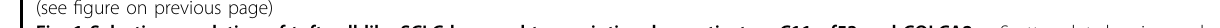
Fig. 1 Selective regulation of tuft cell-like SCLC by novel transcriptional co-activators C11orf53 and COLCA2. a Scatter plot showing each gene ’ s NormLRT score vs publication count. b Scatter plots showing speci fi c genes ’ expression levels vs CERES scores across cancer cell lines. c CellTiter-Glo assay of gRNA-treated NCI-H526 cells. PSMB3, a common essential gene, was a positive control. NT nontargeting. n = 3. d CellTiter-Glo assay of gRNA-treated NCI-H1048 cells. n = 3. e CellTiter-Glo assay of shRNA-treated NCI-H526 cells. n = 3. f CellTiter-Glo assay of gRNA-treated EGFP/ COLCA2-expressing NCI-H1048 cells. n = 3. Statistical analysis was performed within each cDNA group. g Immunoprecipitation-western blot of HEK293T cells expressing HA-COLCA2 (WT or mutant where VKELL in the motif is mutated to DAAPP) and POU2F3. Data were quanti fi ed. h Immunoprecipitation-western blot of HEK293T cells expressing FLAG-POU2F3 and HA-COLCA2-WT/DAAPP. Data were quanti fi ed. i CellTiter-Glo assay of gRNA-treated EGFP/COLCA2-WT/DAAPP-expressing NCI-H1048 cells. n = 3. Statistical analysis was performed within each gRNA group. j Luciferase reporter assay of N-terminal (NT) and C-terminal (CT) domains of C11orf53/COLCA2 fused to GAL4 DNA-binding domain. Reporter gene was driven by a minimal promoter downstream of 9×/0×GAL4-binding sites. n = 6. k Heatmap showing different samples ’ normalized expression levels of up/downregulated genes in NCI-H1048 cells upon COLCA2 knockout (KO). l Venn diagrams showing the overlap of up/downregulated genes in NCI-H1048 cells upon COLCA2/POU2F3 KO. m GSEA analysis of transcriptomic changes in NCI-H1048 cells upon COLCA2/POU2F3 KO. n Model. Two-tailed unpaired Student ’ s t -test was performed for all statistical analysis. * P < 0.05; ** P < 0.01; *** P < 0.001; **** P <